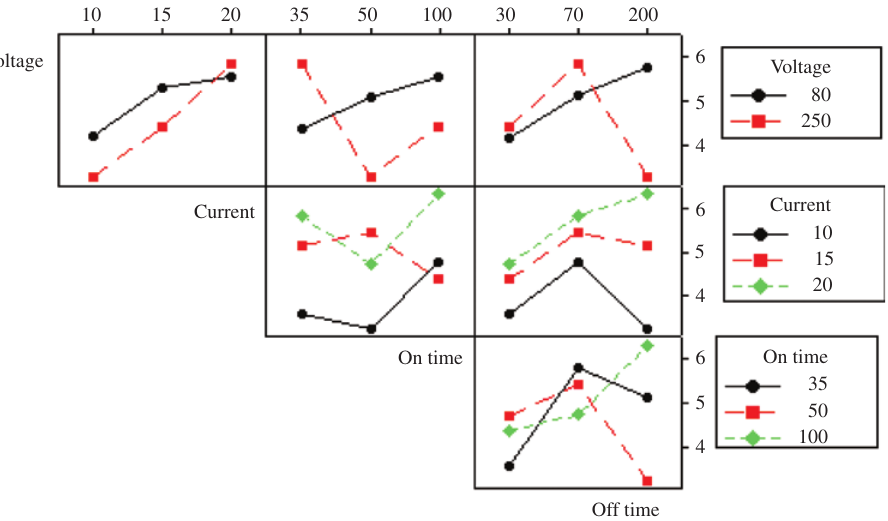
Figure 9: Interaction plot for the process parameters on SR in the machining of 2024 alloy.